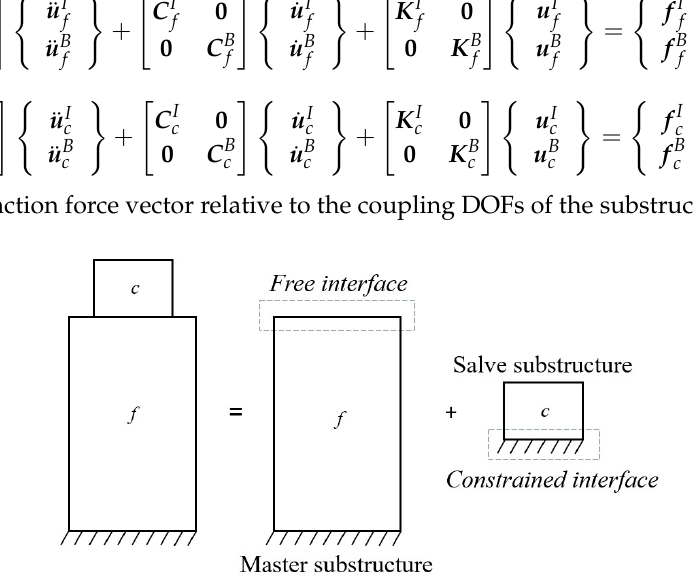
Figure 1. Scheme of a